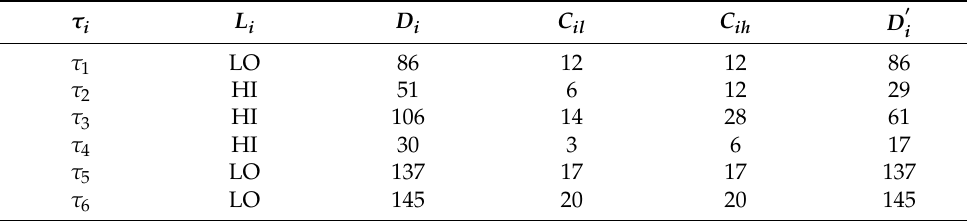
Table 1. Parameter information of task